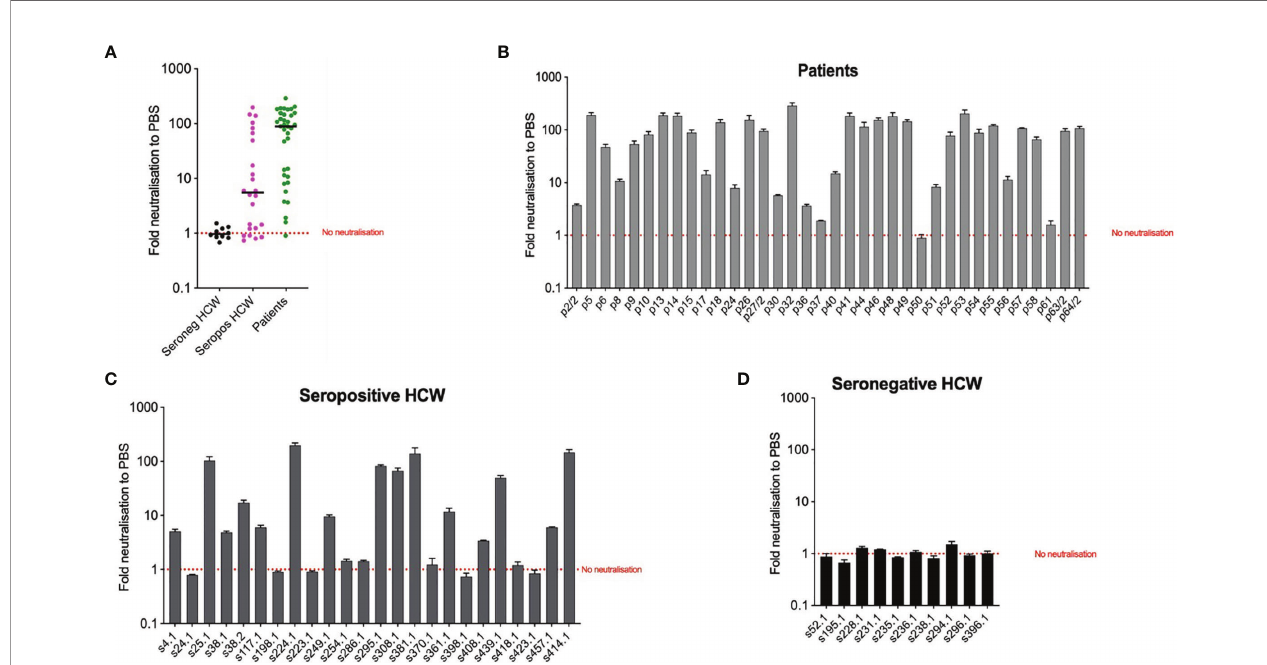
FIGURE 6 | Intracellular neutralisation data from EDNA assay. The results are expressed in genome copies relative to 18S and percentage normalised to PBS. Panel (A) depicts median values of EDNA results of the three cohorts, expressed as Fold neutralisation relative to PBS; Panels (B – D) correspond to individual EDNA results of patients, seropositive HCW and seronegative HCW